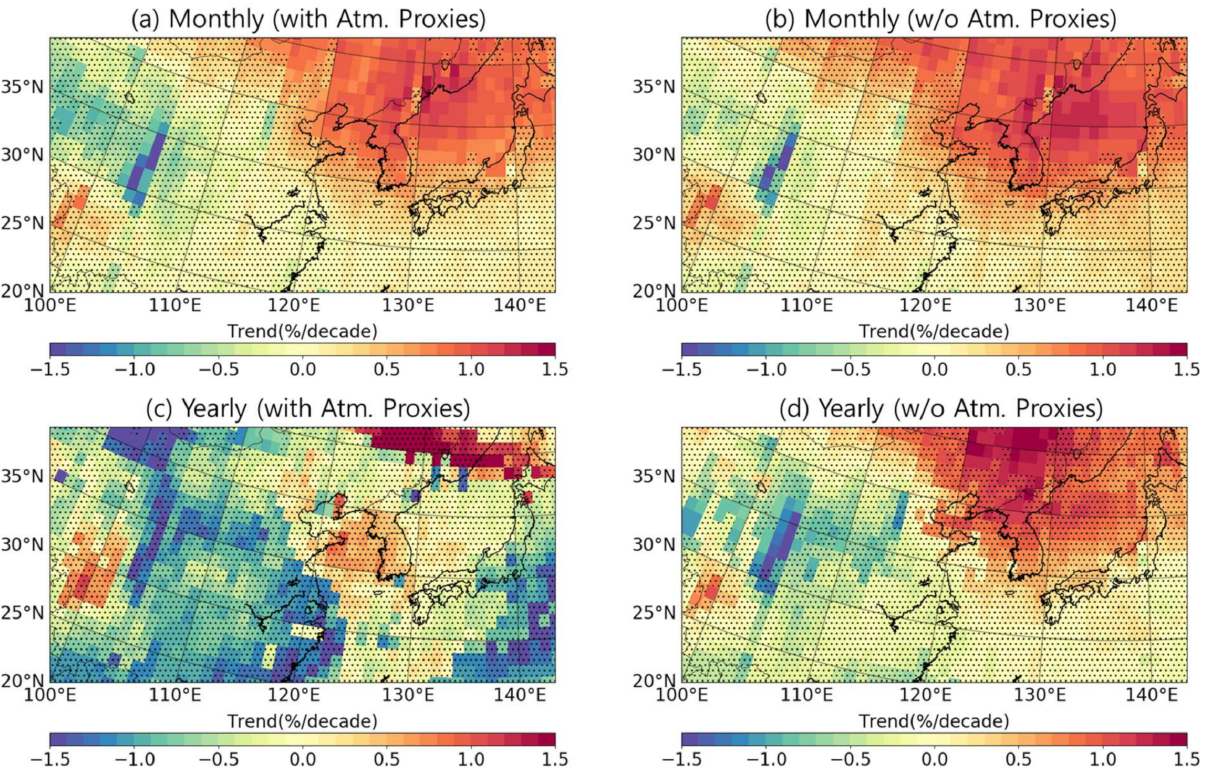
Figure 7. Trend distribution in East Asia from 1997–2017. The left panels show the trends using the atmospheric proxies ( a , c ), while the right panels do not ( b , d ). The top and bottom panels show the trends from the monthly ( a , b ) and yearly ( c , d ) variability, respectively. The dotted pattern denotes areas where trends are not statistically significant at the 2-sigma